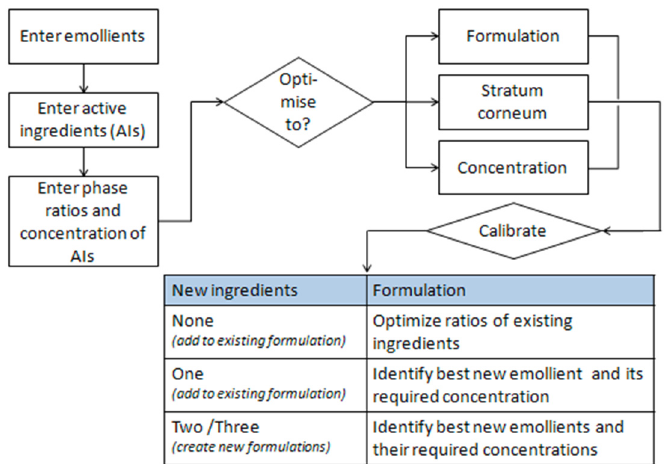
Figure 4. Diagram explaining the functionality of Formulating for Efficacy ® Software. Reprinted and adapted with permissions from [9,10].